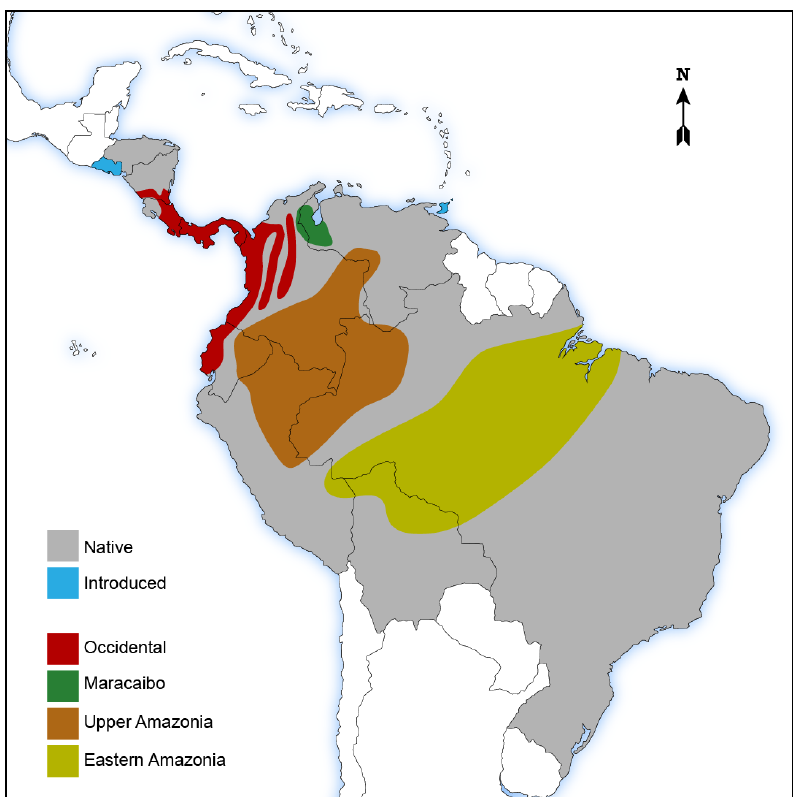
Figure 1. Distribution of Bactris gasipaes Kunth., in tropical Central and South America. Grey: native; light blue: introduced (Trinidad and Tobago, El Salvador). Source: [19]. Shaded areas, main complexes: red: Occidental; green: Maracaibo; brown: Upper Amazonia; yellow: Eastern Amazonia. Source: [20]. Table 1. Common names of Bactris gasipaes according to location.